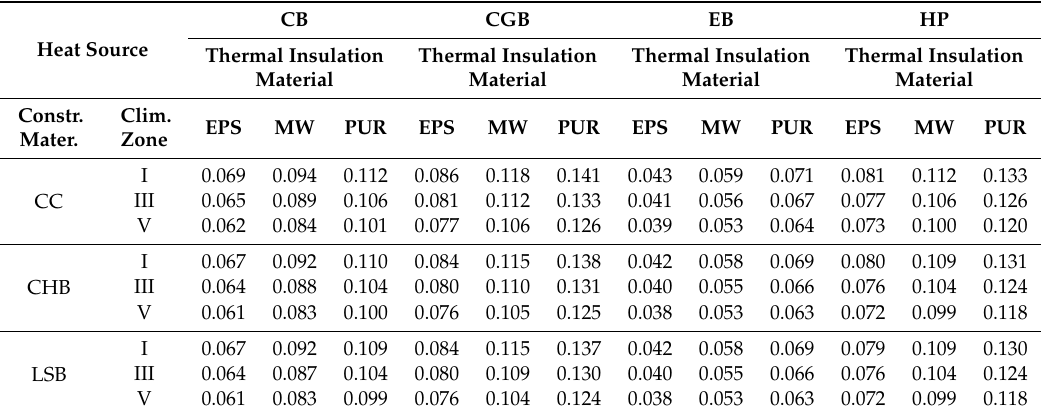
Table 8. Heat transfer coe ffi cient U Eopt values [W / (m 2 K)].